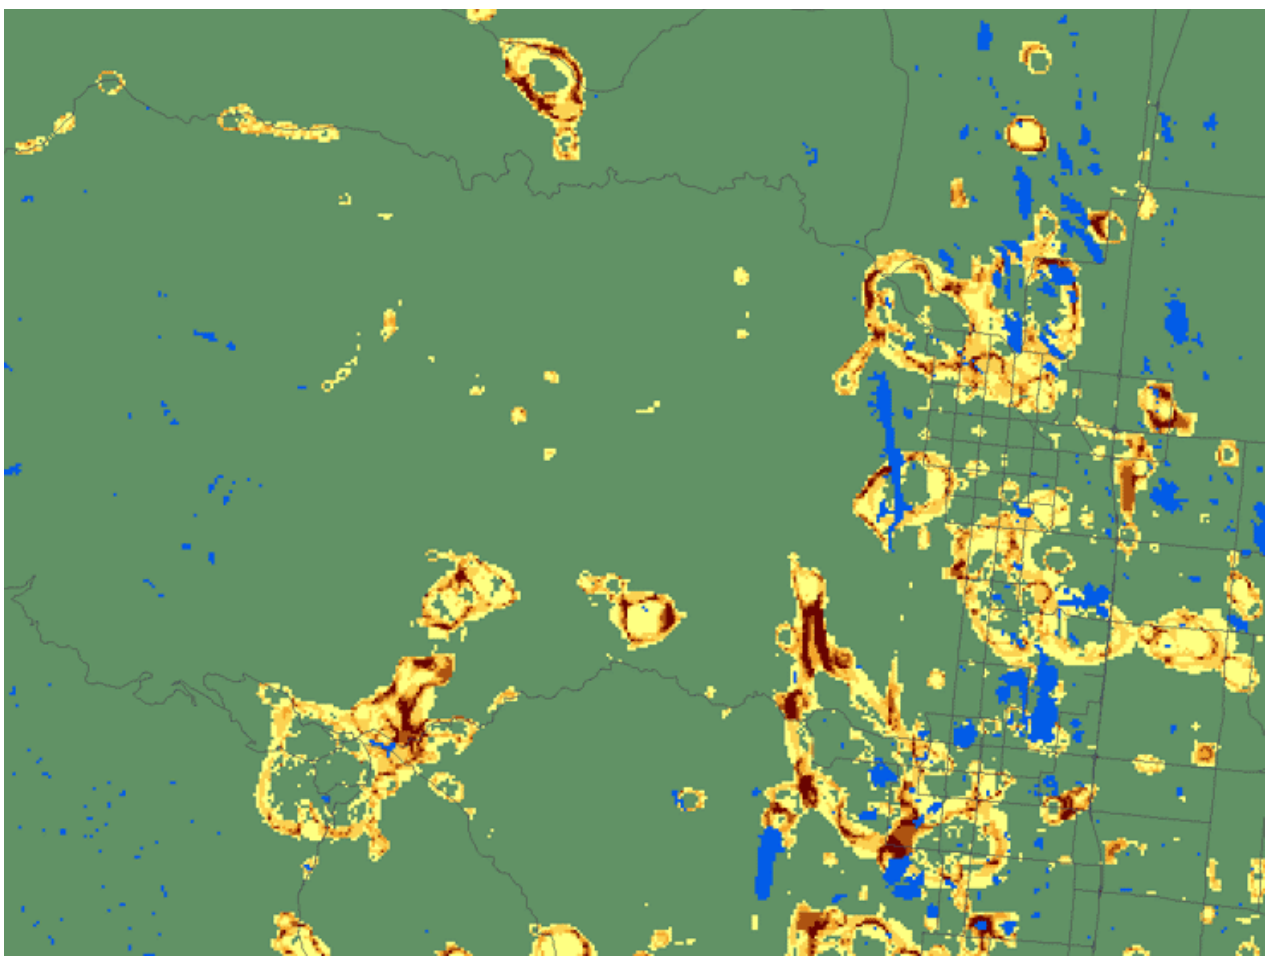
Fig. 18. An exploration of the application of the concept of landscape resilience to identifying the dynamic fringe of exurban development. Cross-scale edge was computed on a portion of landscape around Fort Collins, Colorado, USA using developed/undeveloped patterns at six scales (using 0.2, 0.4, 0.6, 0.8, 1.6, and 2.4 km radius). Locations in red depict high probability of instability, orange moderate instability, and yellow low instability (green is stable, lakes are shown in blue, gray lines show major